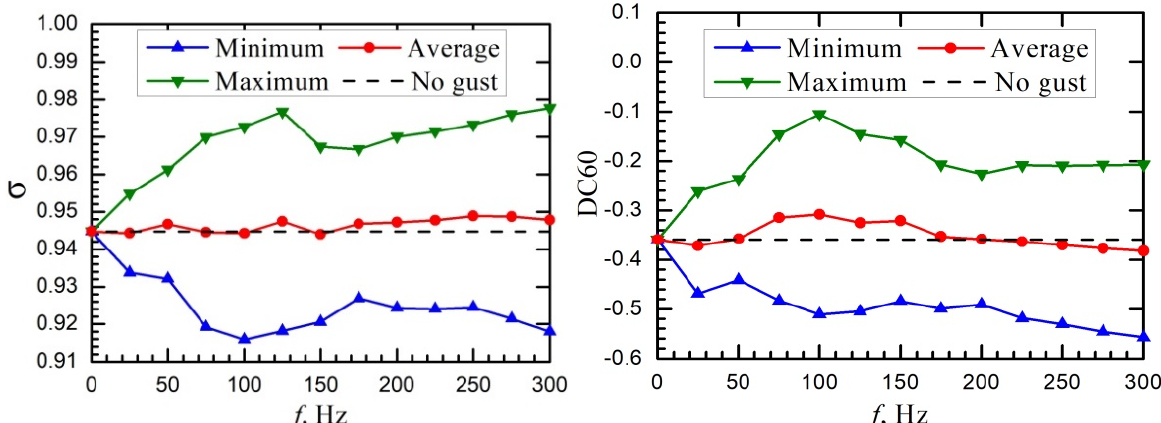
Figure 25. Performance responses of the inlet to the gusts over a wide range of frequency at the constant amplitude of (cid:101) u g = 8 m/s. The mean results of the no-gust case are also shown for comparison.